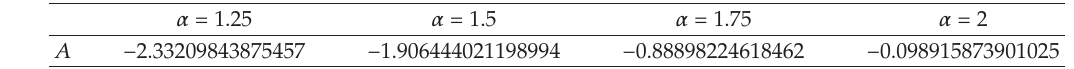
Table 1: Values of A for di ff erent values of α .